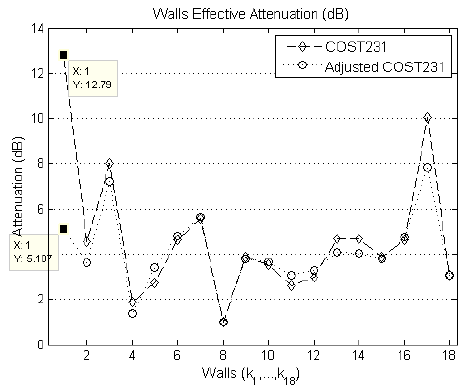
Figure 4. Comparison of wall attenuations for both the COST231 model and its adjusted variation.